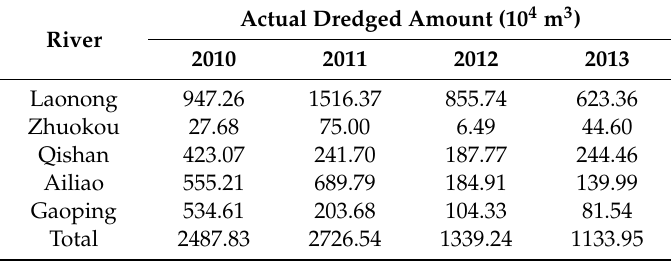
Table 5. The actual dredged sediment deposition amounts from 2010 to 2013 in each river [22].